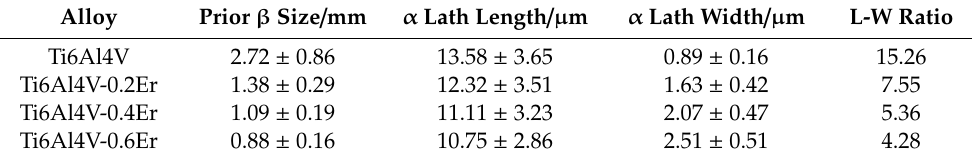
Table 1. Microstructural data of Ti6Al4V- x Er casting alloys.